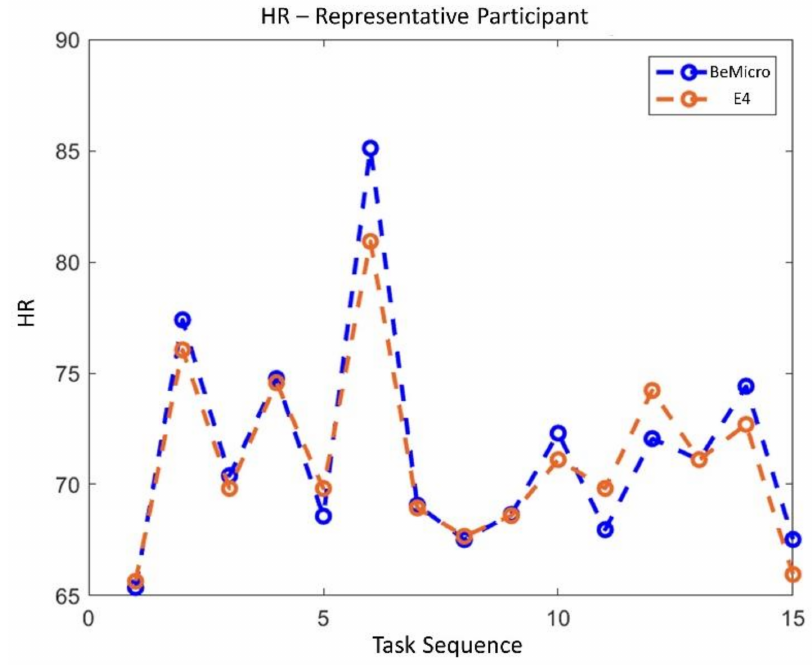
Figure 12. Time dynamics of EBR across all experimental task and conditions for both consumer wearable (red) and laboratory device